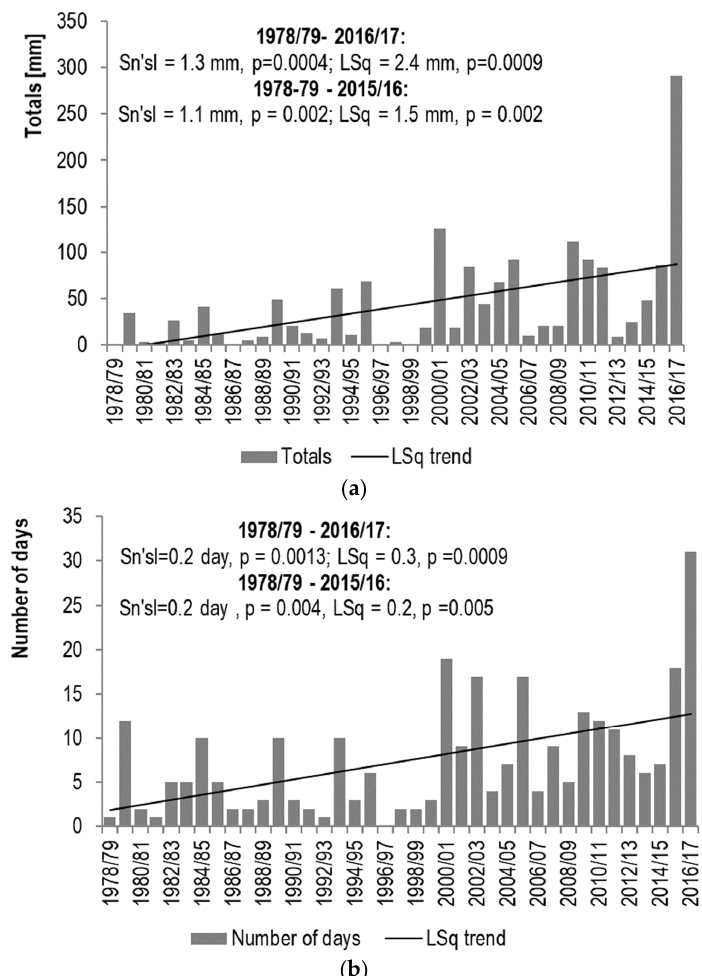
Figure 4. Long-term variability of winter rainfall totals ( a ) and frequency ( b ) in Hornsund in the period October 1978–May 2017. Winter is defined as the period between May and October. Trend magnitudes calculated with Sen’s slope (Sn’sl, change per year) and linear regression of least square method (LSq, change per year), statistical significance ( p ) checked with Mann–Kendal and t-tests, respectively.